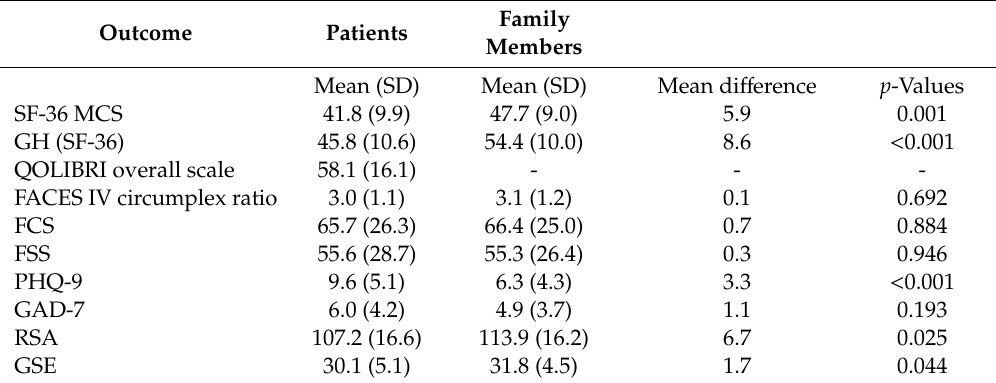
Table 3. Intergroup di ff erences on self-reported outcome